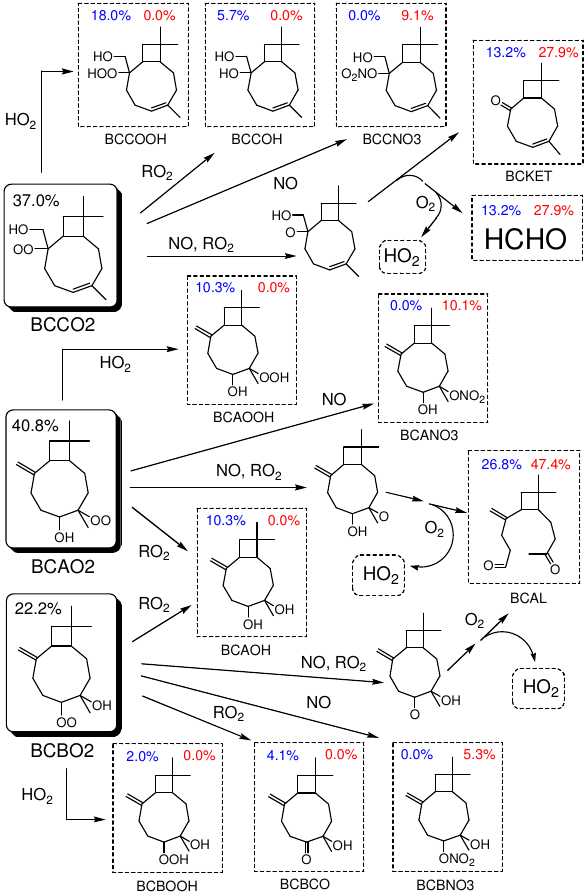
Fig. 4. Simplified schematic of the first-generation product distri- bution from the OH-initiated degradation of β -caryophyllene, as represented in MCM v3.2. The peroxy radicals, BCAO2, BCBO2 and BCCO2 are formed from the initial sequential addition of OH and O 2 to β -caryophyllene. The displayed (molar) product yields correspond to 298K and 760 Torr. Yields in blue are for NOx-free conditions; yields in red are for conditions when there is sufficient NO present to provide the exclusive reaction partner for the RO 2 radicals (but insufficient to react significantly with RO radicals).